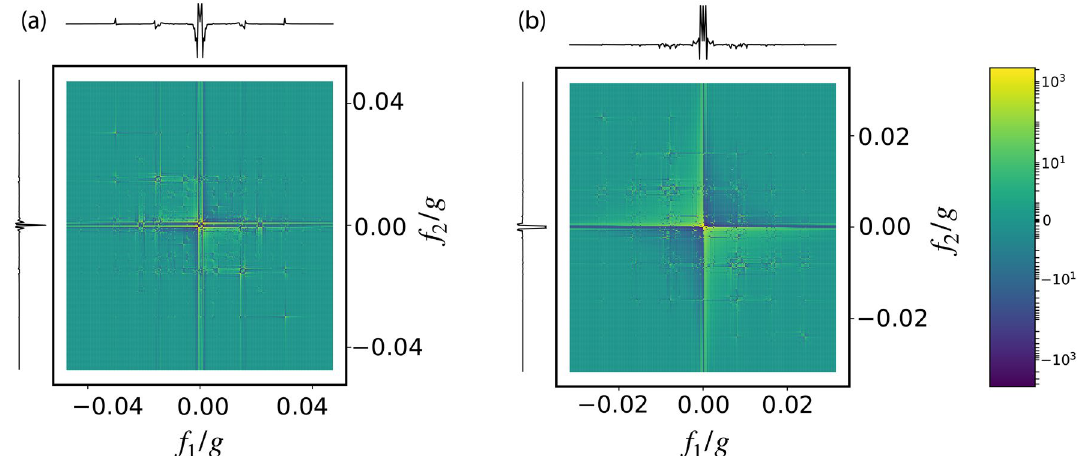
Figure 6. ( a ) PrePSy applied on a single NV which is part of a closed chain of 3 other NVs placed in a cavity. 4 1 i 0 i The Hamiltonian is H eff 1 �� 0 i 1 i 1 | + H . C . where | a 5 � = | a 0 � for a = 0, 1 . The number of major i 1 | = (cid:31) + + = peaks visible with 1D spectroscopy is 6, shown above the 2D image (ignoring the low frequency peaks). In 2D spectroscopy approximately 7 major peaks in the 2nd and 4th quadrant each. ( b ) PrePSy applied on a single NV which is in the cavity with two other NVs interacting in a pairwise manner. The Hamiltonian is 3 H eff 1 i 0 j 0 i 1 j H . C . . The number of major peaks visible with 1D spectroscopy is 6, shown above i j | i , j = (cid:31) �� | + ; �= the 2D image (ignoring the low frequency peaks). In 2D spectroscopy approximately 9 major peaks in all